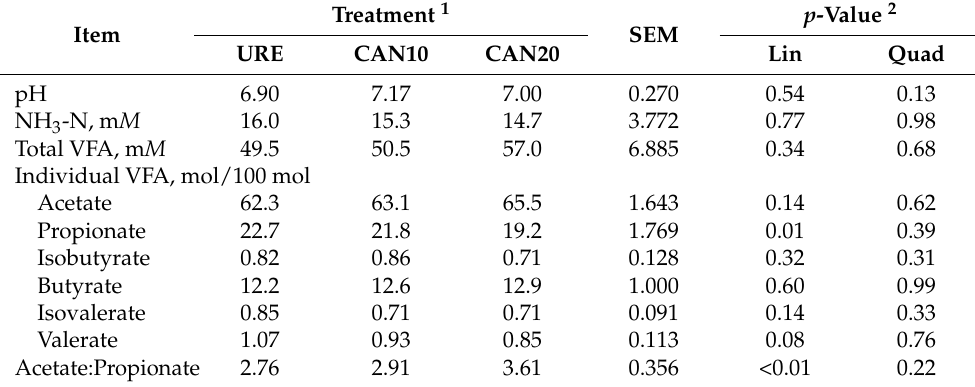
Table 5. Effects of calcium-ammonium nitrate (CAN) fed to lactating dairy goats on ruminal pH, NH 3 -N concentration, and VFA